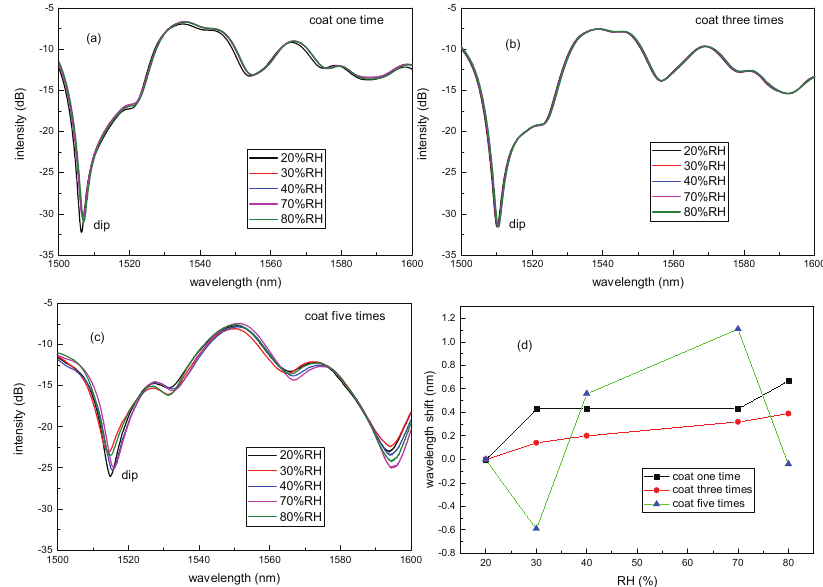
Figure 4. Transmission spectra at different RH values of the sensor coated by 0.05 wt/vol % agarose mixture in different numbers: ( a ) coat one time; ( b ) coat three times; ( c ) coat five times. ( d ) The wavelength shift of the dip in different